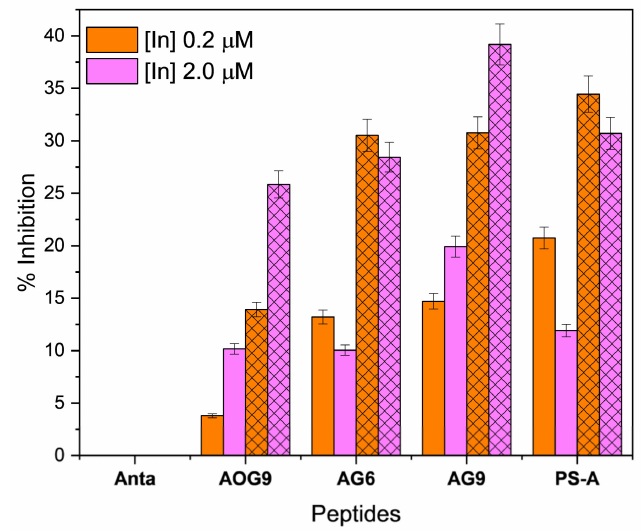
Figure 4. Percentage of tyrosinase inhibition determined by UV-VIS spectroscopy at 303 (color) and 477 nm (color plus grid) at different concentration of inhibitors